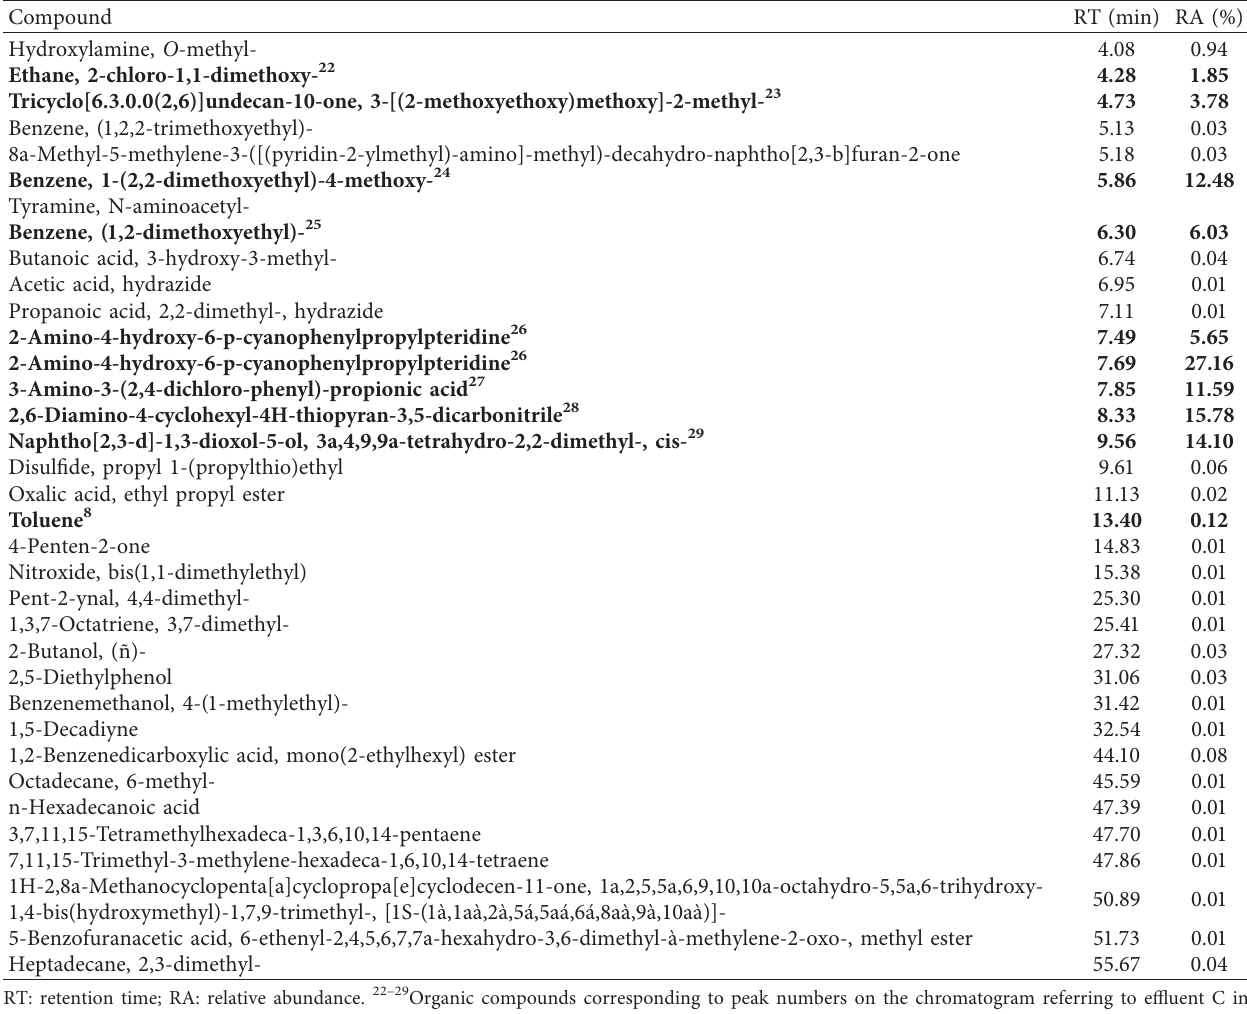
Table 4: Organic compounds identified in real textile effluent